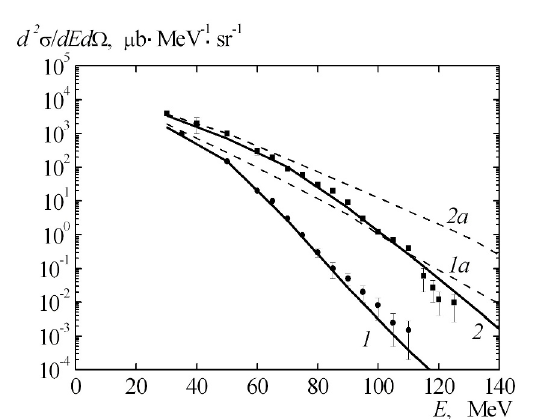
Figure 1. The energy spectra of the protons emitted in the reaction 16 O + 27 Al → p + X at an angle of 30 o with the 16 O ion energy of 207 MeV (curve 1) and 310 MeV (curve 2). The calculated spectra are shown by solid lines and experimental data [8] are shown by points. The dashed curves la and 2a correspond to calculations without taking into account an amendment for the microcanonical distribution. In the first case, the average temperature of the hot spot < T h > is equal to 8.3 MeV, the chemical potential < µ T > is equal to 32.9 MeV, in the second case, respectively, < T h > ≈ 10 MeV, < µ T > ≈ 31.2 MeV, the average radius of the hot spot < R h > ≈ 2 fm